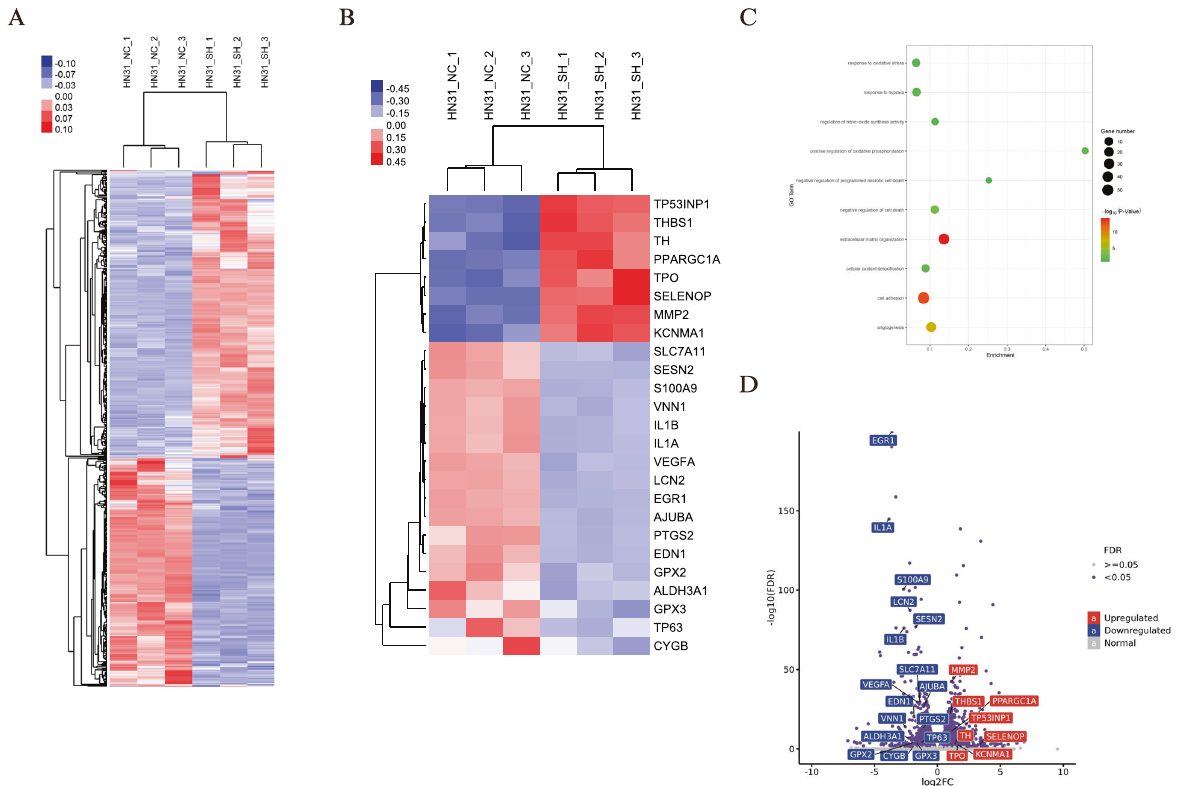
Fig. 4 RNA-seq shows Δ Np63 α knockdown changed the landscape of oxidative stress. A . Heatmap of all differentially expressed genes between HN31-sh Δ Np63 α cells and HN31-sh Δ Non cells (log 2 fold change >1 or < -1, FDR < 0.05). B . Heatmap of differentially expressed genes associated with oxidative stress and antioxidant defense. C . Gene Ontology (GO) was analyzed and demonstrated for identifying and visualizing enriched GO terms. D . Scatter plot of differentially genes after Δ Np63 α knockdown. Blue and red indicate the downregulated and variation upregulated,